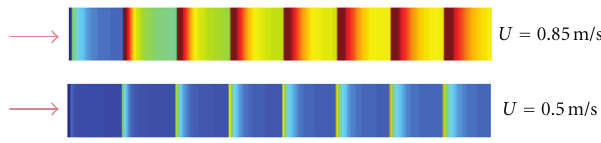
Figure 2: Axial variation in local interphase mass transfer coe ffi -